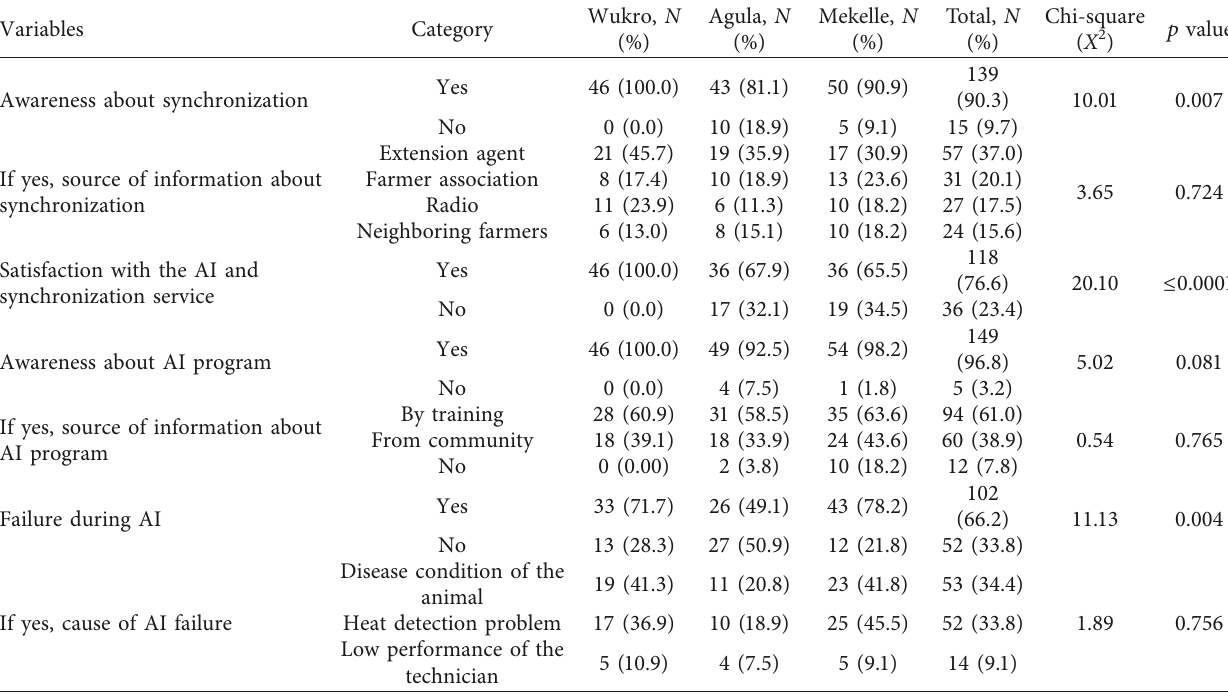
Table 4: Knowledge and attitude of farmers regarding synchronization and AI programs at the study sites.